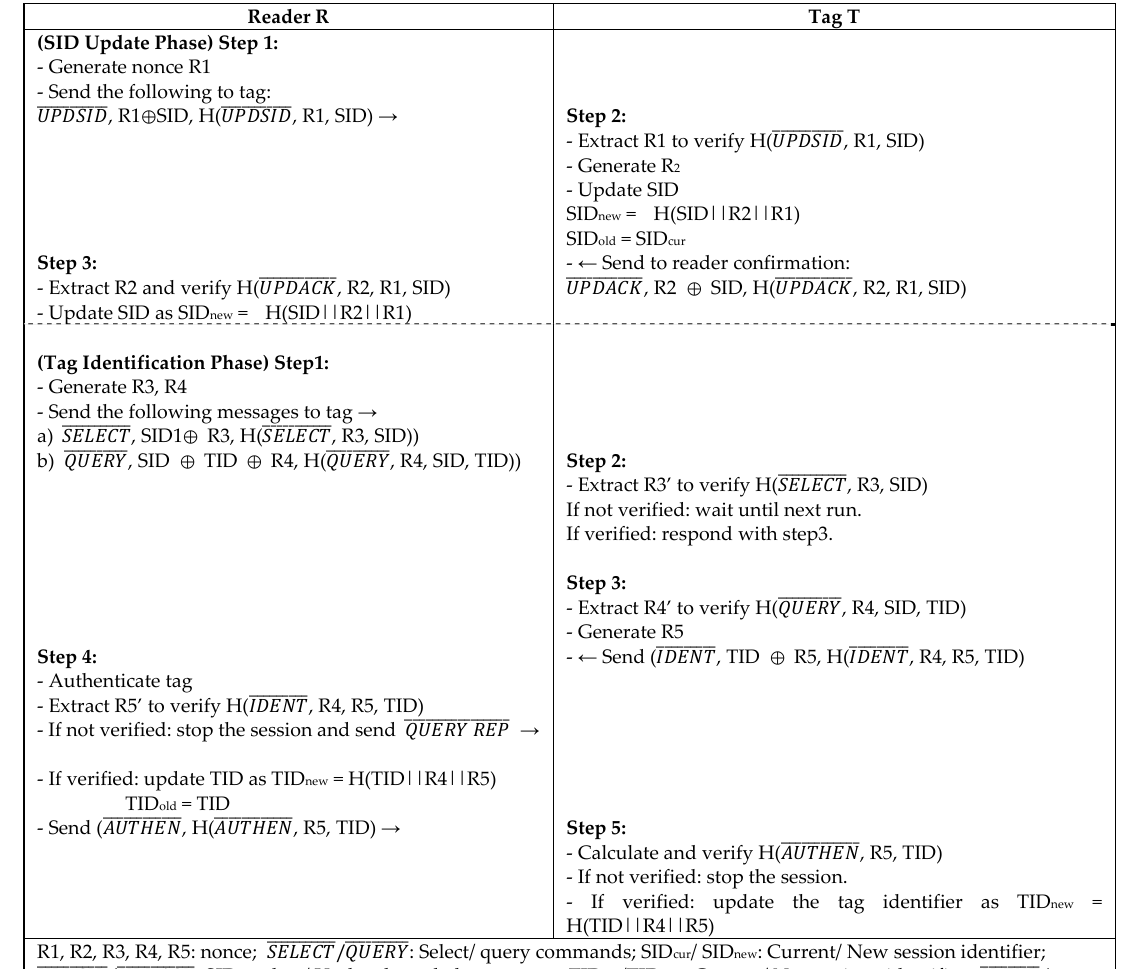
Figure 9. Anti-Counting Security Protocol (ACSP++) by X. Chen.